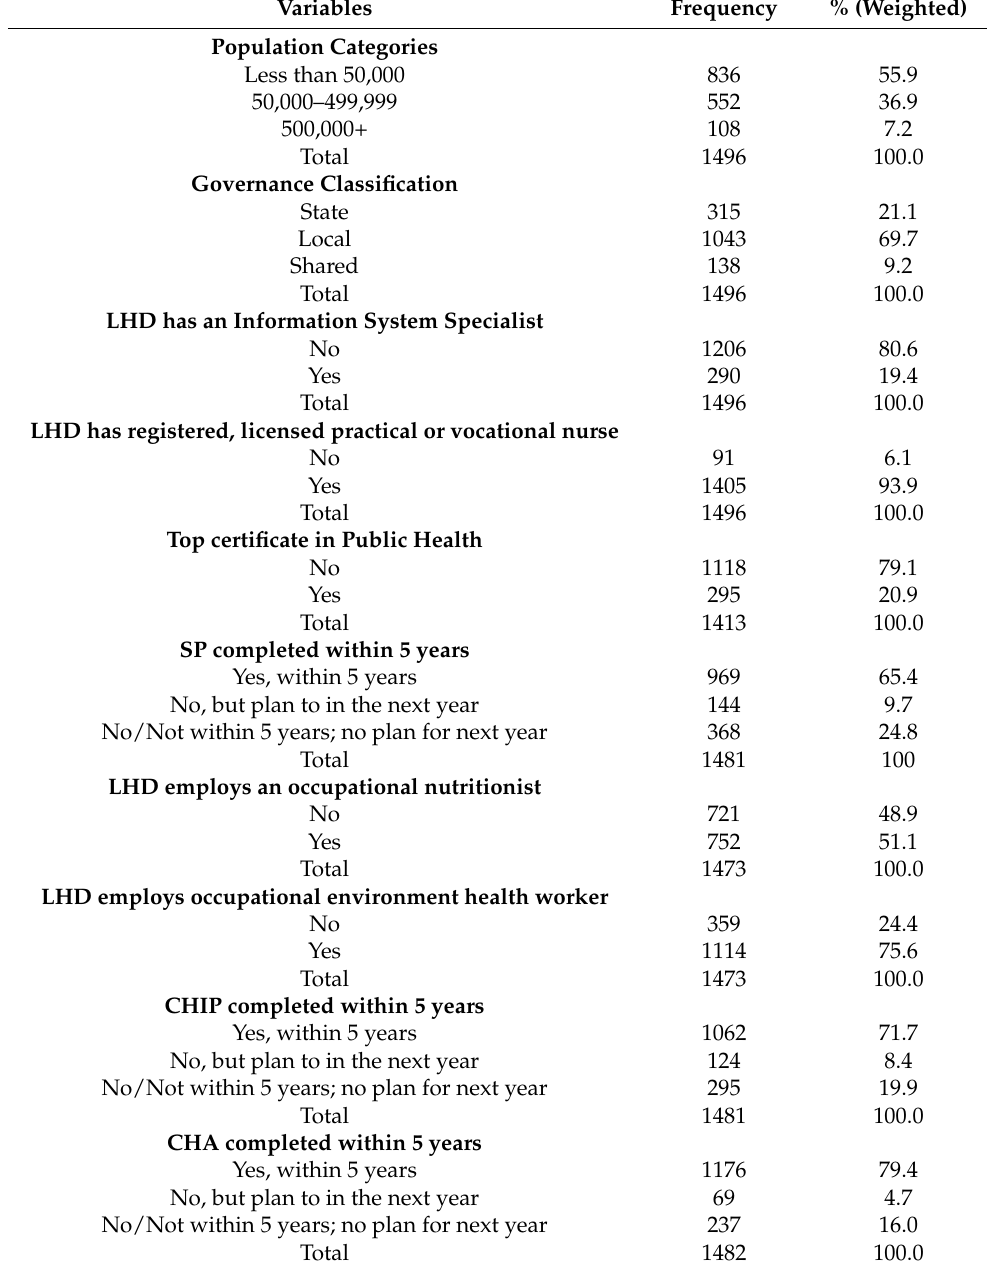
Table 1. Descriptive Statistics for LHD characteristics. Profile of LHDs,